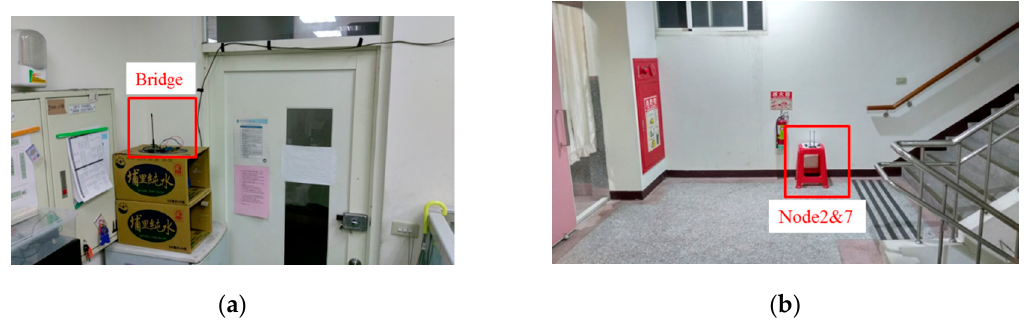
Figure 3. ( a ) The placement of the bridge; ( b ) the placement of node 2 and node 7.